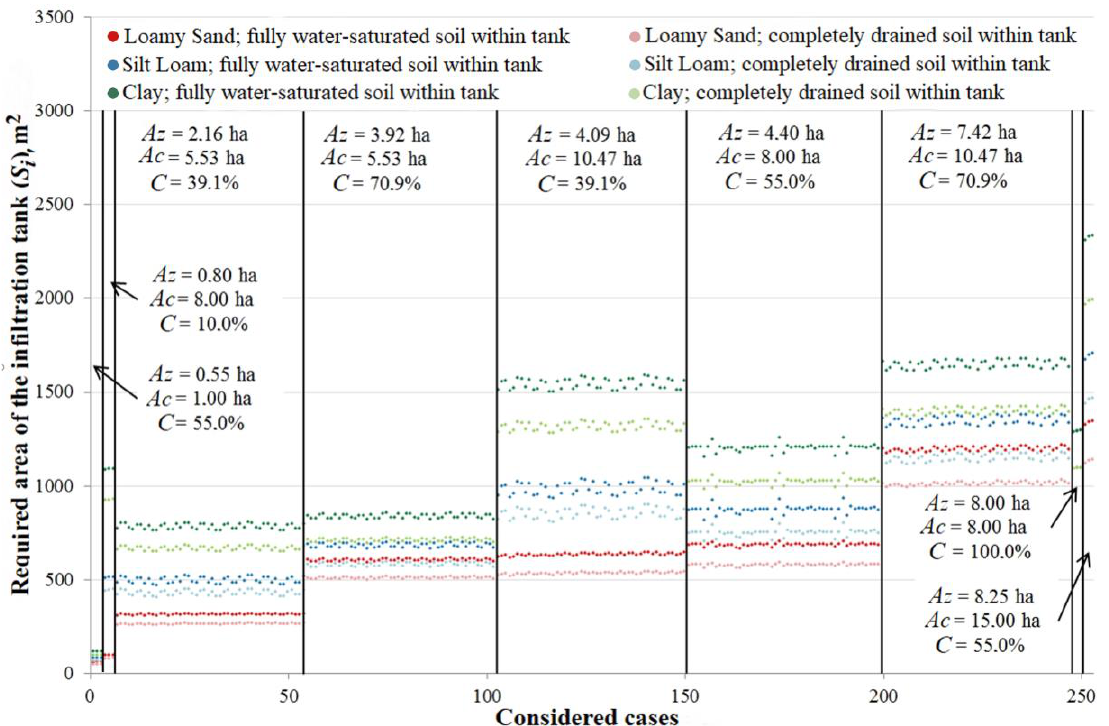
Figure 12. Results of the simulations carried out for the infiltration tank ( A z — reduced catchment area; A c — total catchment area; C — runoff coefficient).